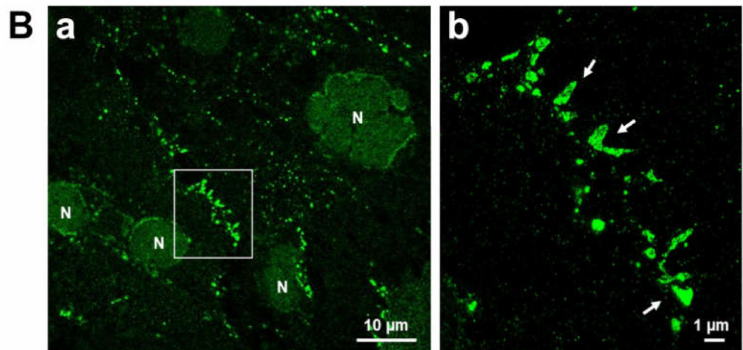
Figure 1. Intercellular connections and intercalated discs in iPSC-cardiomyocytes. ( A ) Ultrastruc- ture of two neighboring iPSC-cardiomyocytes showing the intercalated disc-like structures between both cells reminiscent of a stair case. ( a ) Transmission electron micrograph; ( b ) enlargement of the white box indicated in ( a ), ( c ) detail of ( b ), visualizing points of cell adhesion and gap junction plaques between both cardiomyocyte membranes (arrows). ( B ) Immunolabeling of Cx43 in iPSC- cardiomyocytes. ( a ) Overview image taken by a confocal microscope; ( b ) super-resolution confocal image of the magnified area indicated in ( a ), recorded with a STED microscope (with courtesy to Abberior Instruments GmbH, Heidelberg, Germany). White arrows indicate examples of the appear- ance of gap junction plaques built from Cx43 proteins. Abbreviations: MF: myofibrils, N: nucleus, SR: sarcoplasmic